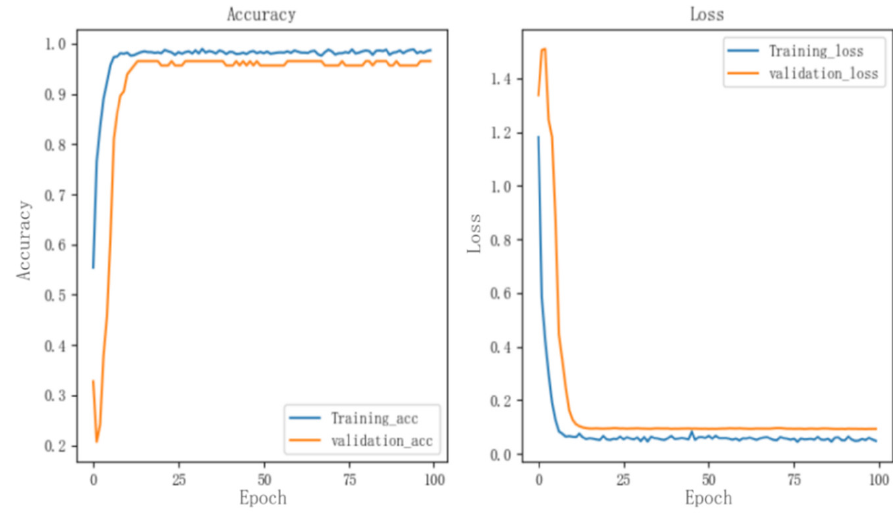
Figure 13. Accuracy and loss function of VGG16 model.